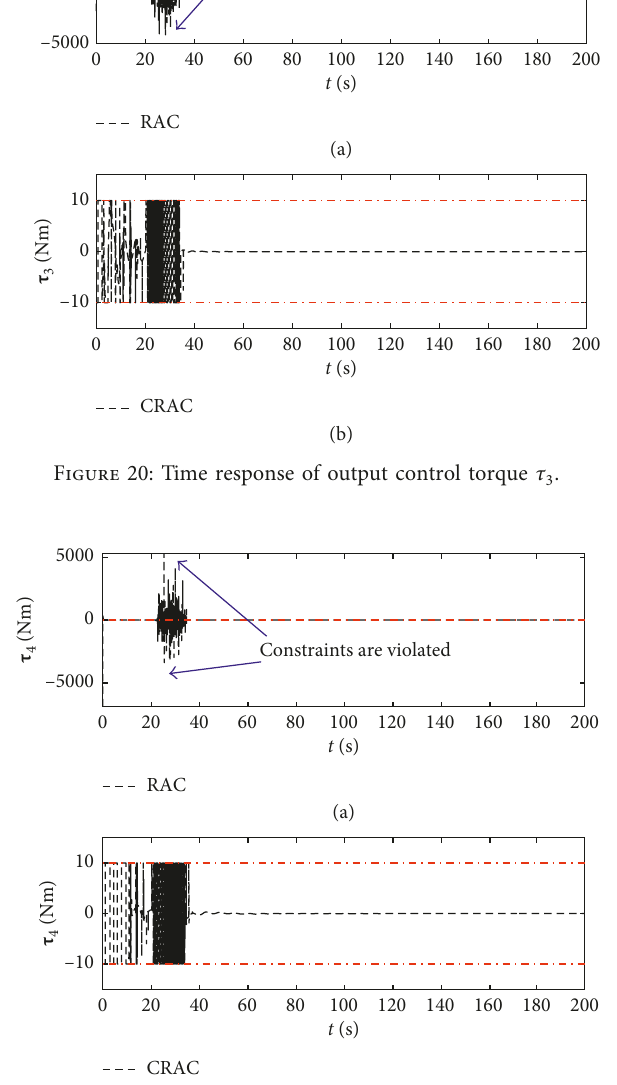
Figure 21: Time response of output control torque τ Table 3: Steady observation errors of modal observer. Mode 1 η 1 7.381 |